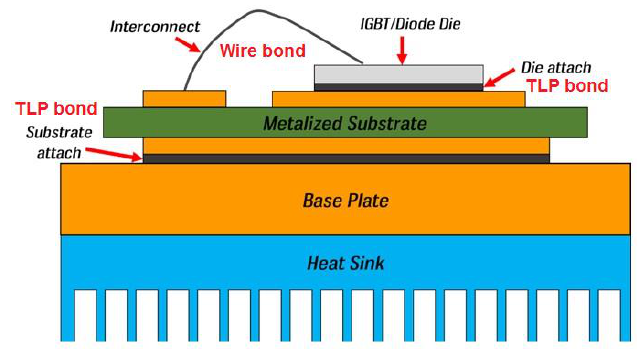
Figure 1. Schematic diagram of a power module.